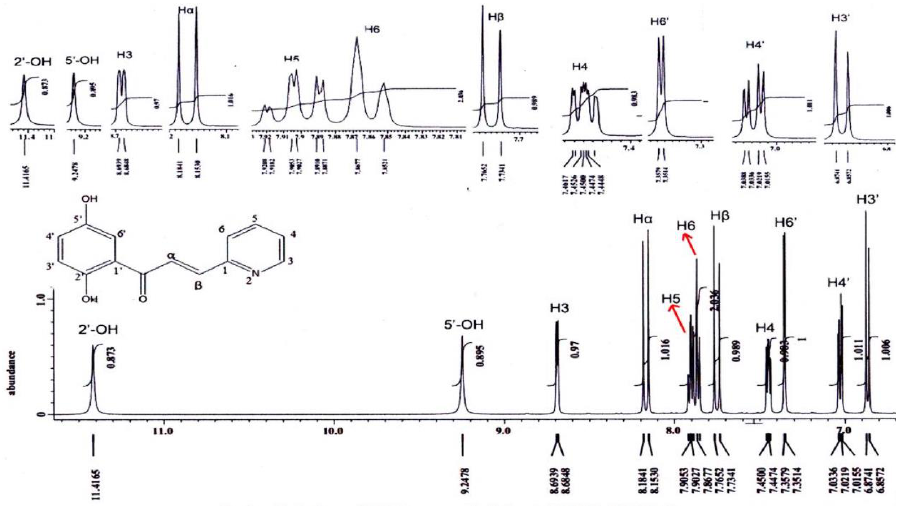
Figure 8. The 1 H-NMR spectrum of the synthesized compound (500 MHz,